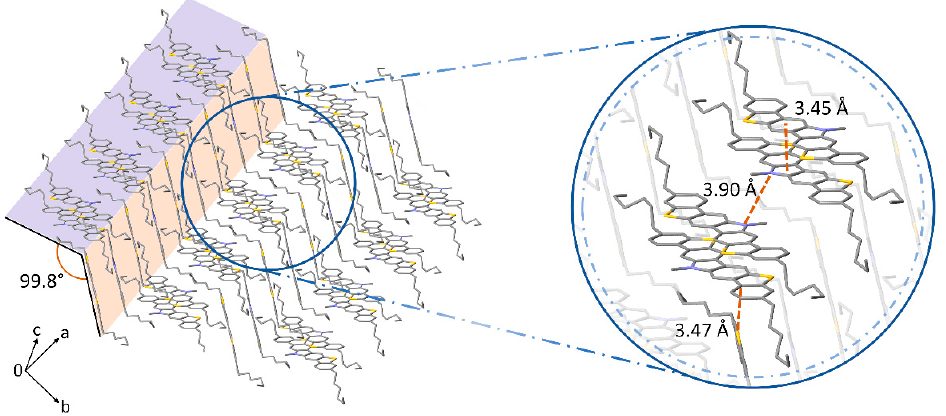
Figure 6. Single crystal structure of compound 1b , with the corresponding interplanar angle. The amplified region shows the π - π stacking distance (3.45 Å), the N···N distance (3.90 Å) between di- amplified region shows the π - π stacking distance (3.45 Å), the N ··· N distance (3.90 Å) between dimers mers and the edge-to-face S··· π interaction (3.47 Å). Hydrogens have been excluded for clarity. and the edge-to-face S ··· π interaction (3.47 Å). Hydrogens have been excluded for